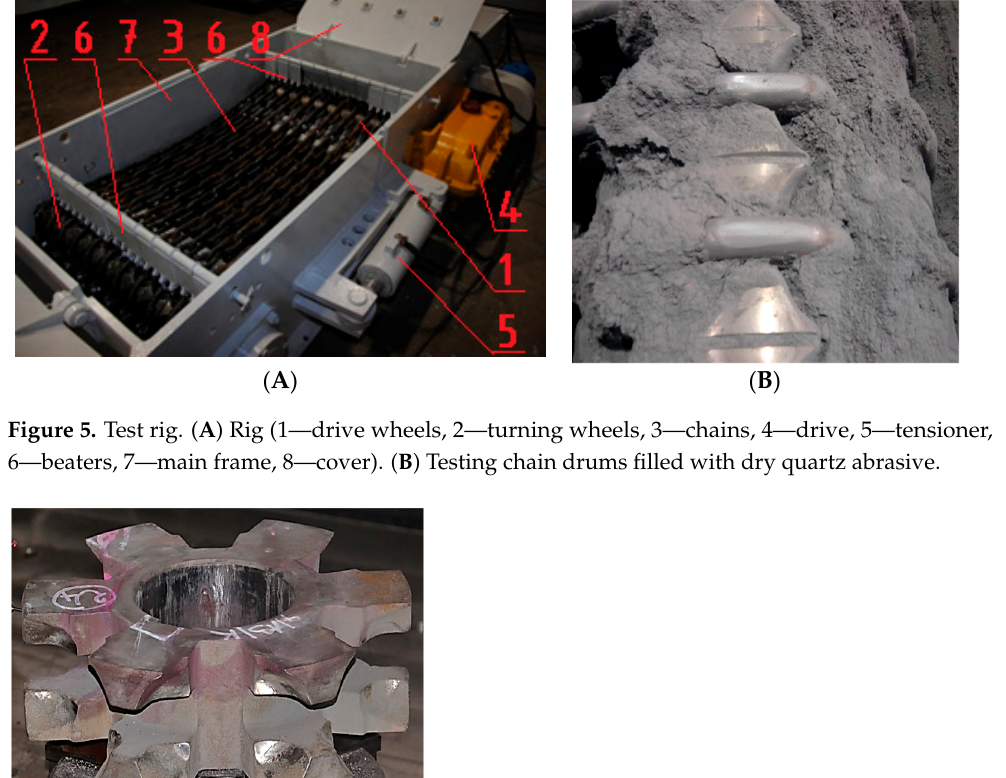
Figure 6. Tested chain wheel. Table 4. Combinations of damaging agents.